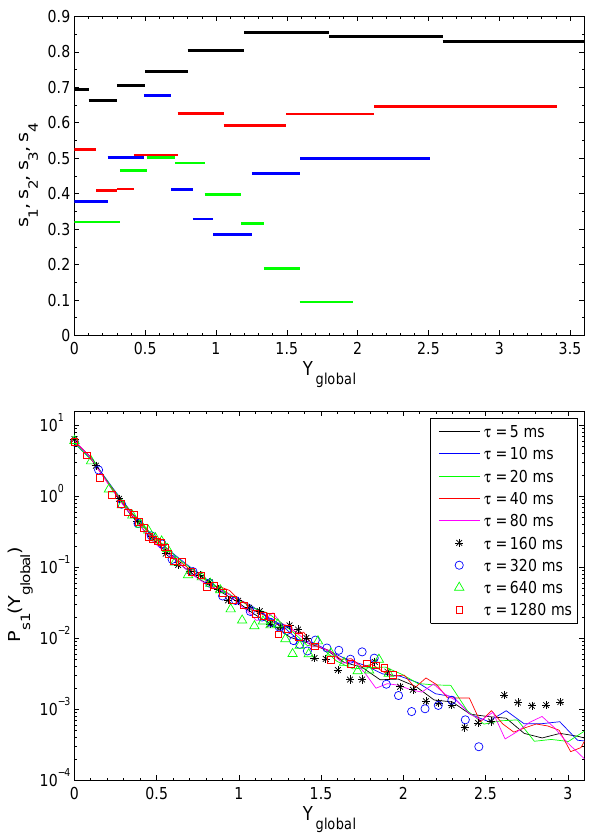
Fig. 7. Top: rank-ordered spectra s 1 (black), s 2 (red), s 3 (blue), and s 4 (green) over the ranges of Y global . Bottom: global scaling function P s1 (Y global ) obtained from the PDFs at all the time scales of the four